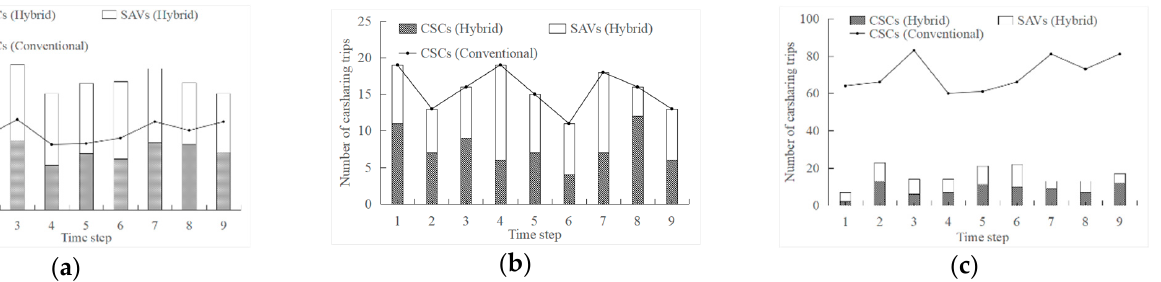
Figure 7. The number of carsharing trips for each cluster in both carsharing systems: ( a ) Cluster 1, ( b ) Cluster 2, ( c ) Cluster 3.